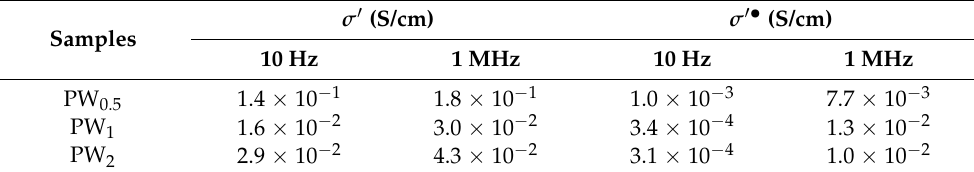
Table 5. Complex conductivity